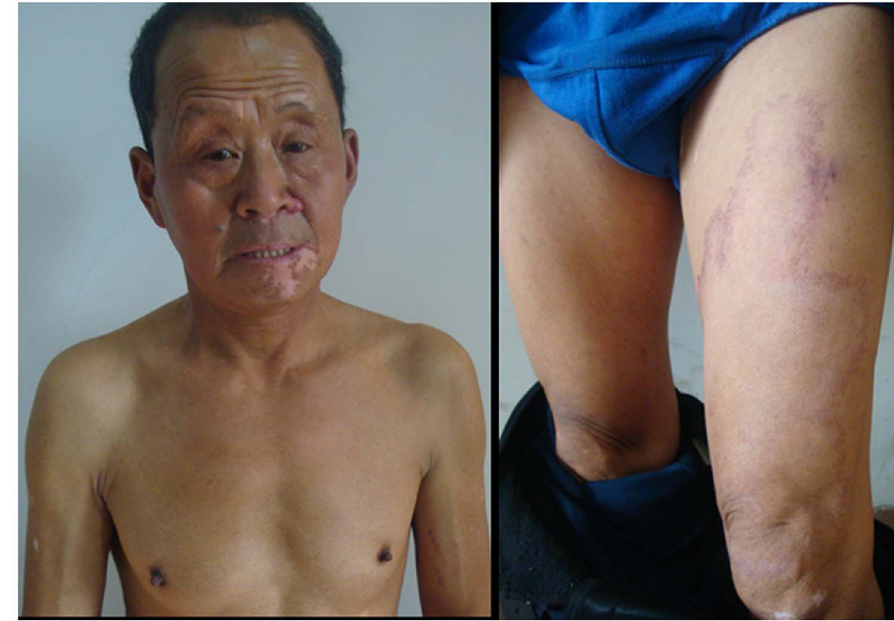
Figure 4. Clinical manifestations of the first patient after the treatment. The rash of DDS syndrome disappeared and only original lesions could be found on his leg.